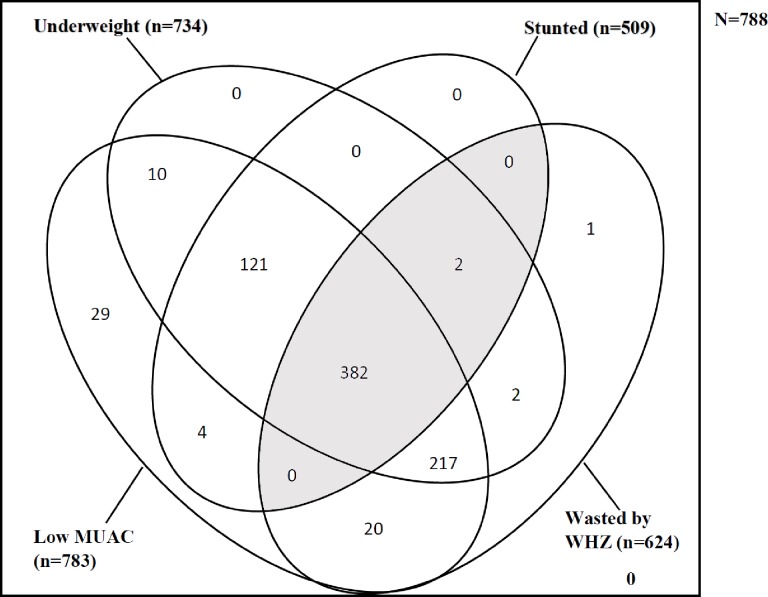
Venn diagram showing wasting, stunting, underweight and low MUAC overlaps in the study sample (N = 788).Legend: The gray shaded areas depict intersection between wasting and stunting; WaSt.